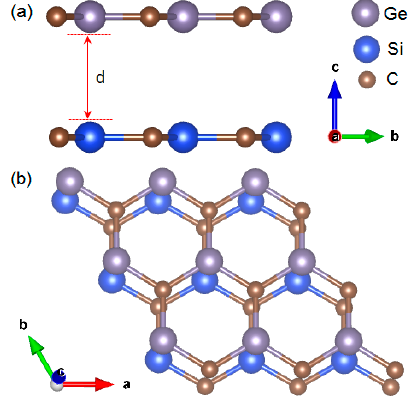
Figure 1. (Color online) ( a ) Side and ( b ) top views of the SiC / GeC van der Waals (vdW) heterostructure. The interlayer distance (d) changes along the c